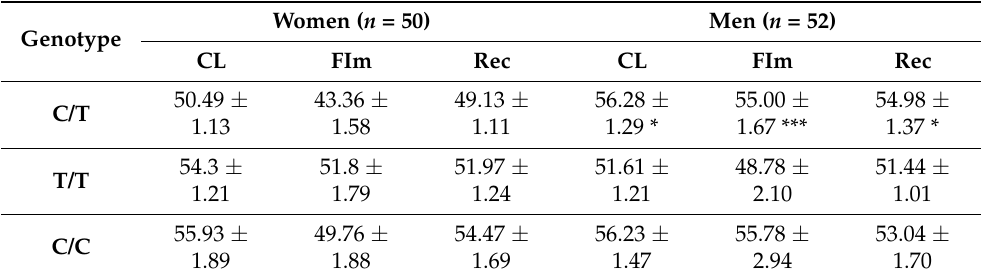
Table 6. Difference in dicrotic index (DCI, %) between men and women with matched ADRA1A p.Arg347Cys (rs1048101) genotypes.